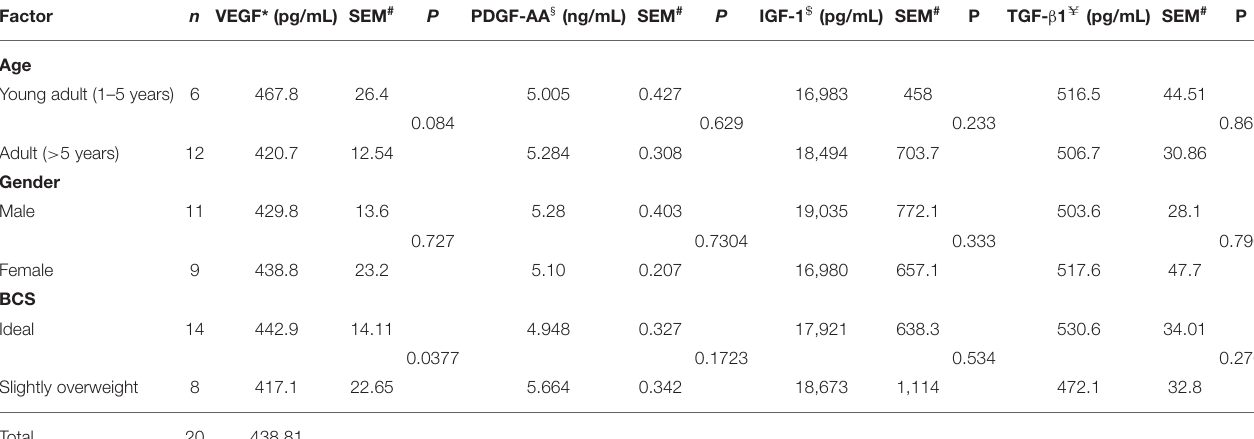
TABLE 5 | Statistical analysis of demographic variables and mean of growth factors determined by ELISA test.